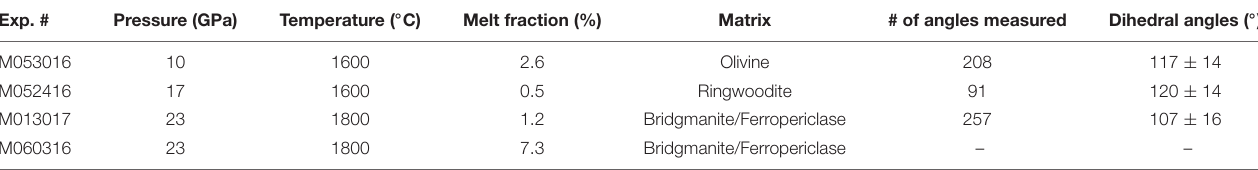
TABLE 1 | Summary of experimental conditions and results.